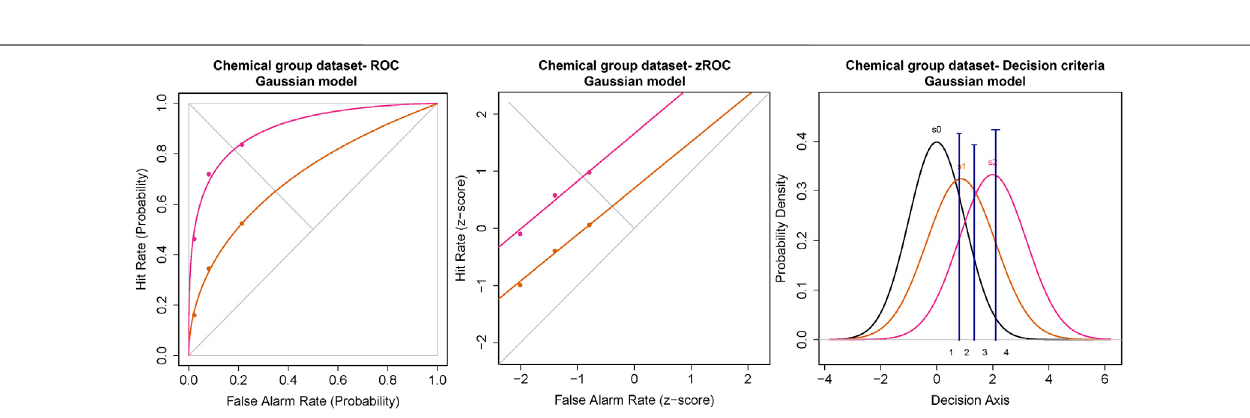
FIGURE 6 | ROC and Gaussian distribution for the chemical stimuli. The orange line represents the threshold stimuli followed by pink (2x threshold). The density functions in black (s 0 ) represent the noise distribution.